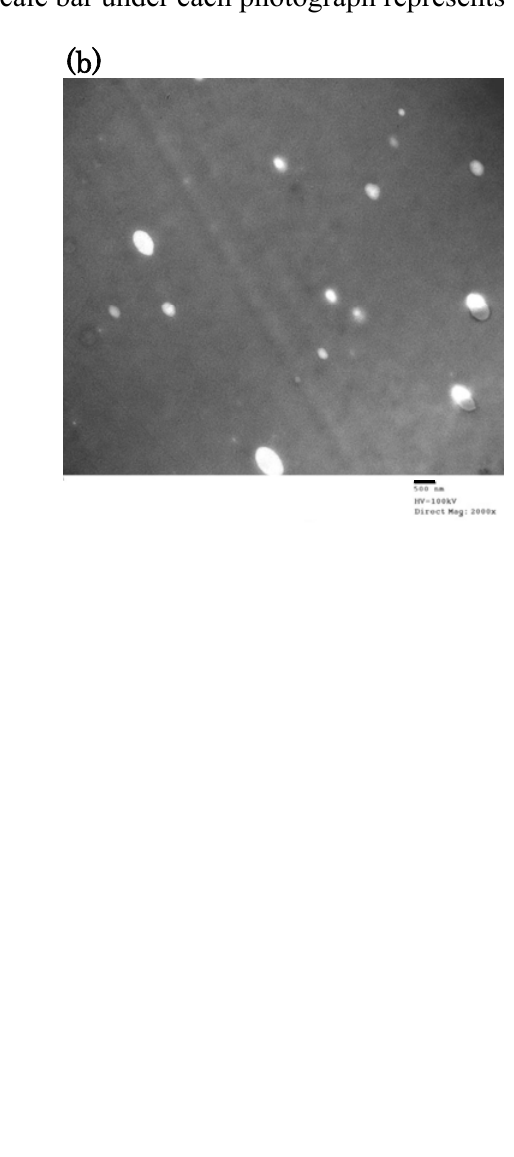
Figure 6. TEM photographs of (a) DFT-TMDS-BMI, (b) DFT-DMS20-BMI, and (c) DFT-DMS40-BMI. The acceleration voltage was 100 kV. The obscure small spots are highlighted in the photograph (c). The scale bar under each photograph represents 500